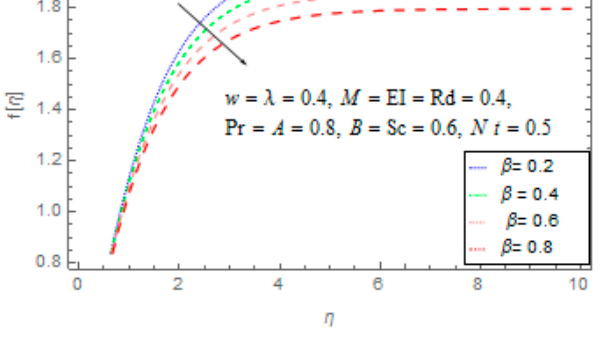
Figure 6. Influence of β on f ( η ) .